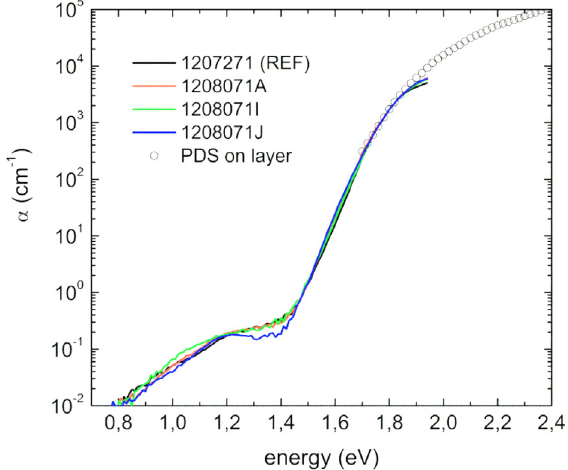
Fig. 3. Absorption coefficient of pm -Si:H absorber layer in p - i - n devices fabricated on Asahi SnO 2 , LPCVD ZnO and sp-e ZnO substrates versus photon energy measured by FTPS. The absolute scaling is made relative to i -layer on Corning glass measured by photothermal deflection spectroscopy (PDS).